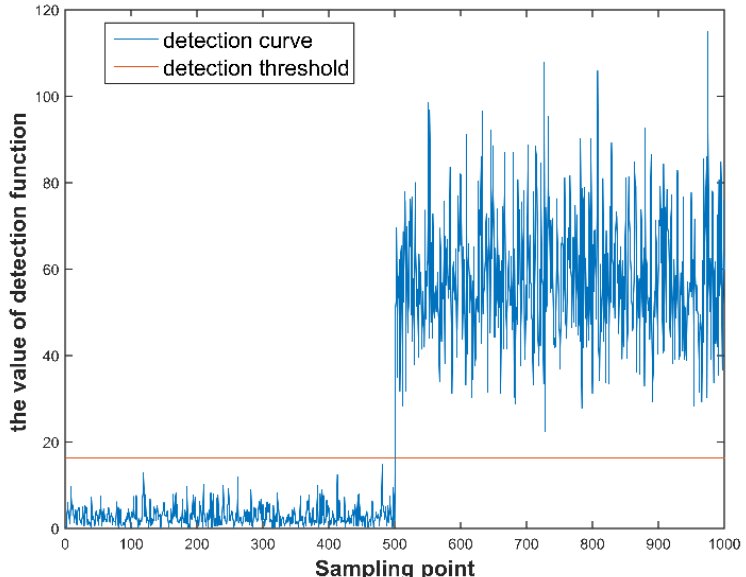
Figure 7. Fault detection curve for double faults.